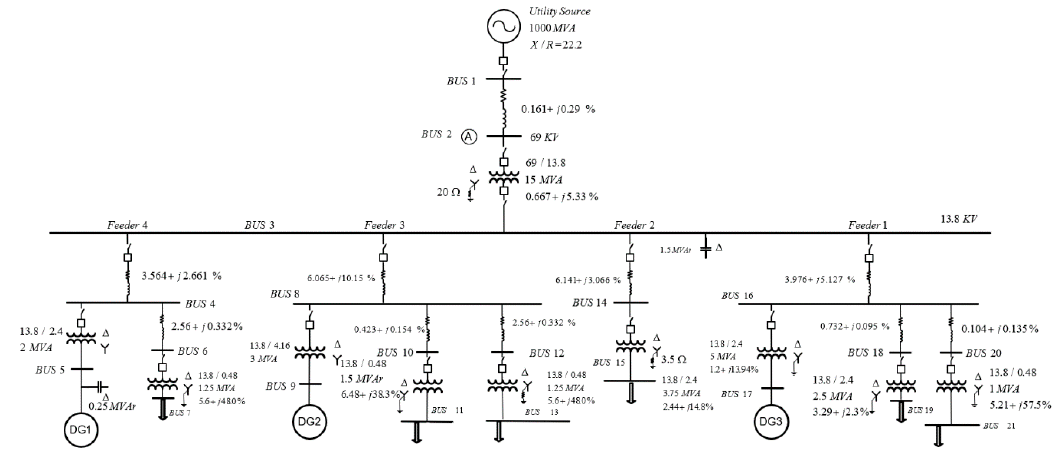
Figure 1. One-line diagram of the IEEE 21-bus microgrid